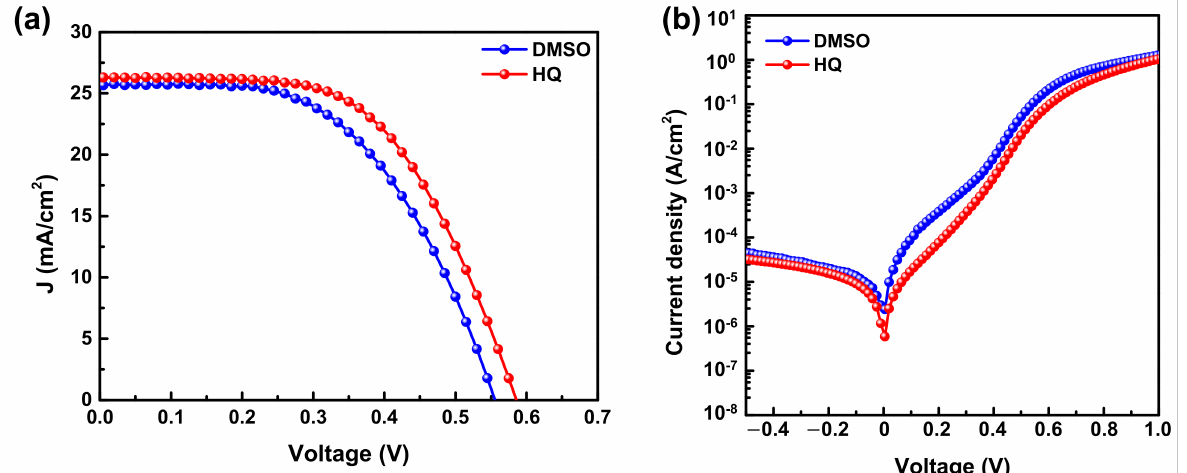
Figure 4. Current density vs. voltage curves of Si/PEDOT:PSS(DMSO, HQ) HSCs measured under ( a ) 100 mW/cm 2 illumination (AM1.5) and ( b ) dark conditions. Table 2. Photovoltaic parameters of Si/PEDOT:PSS HSCs.